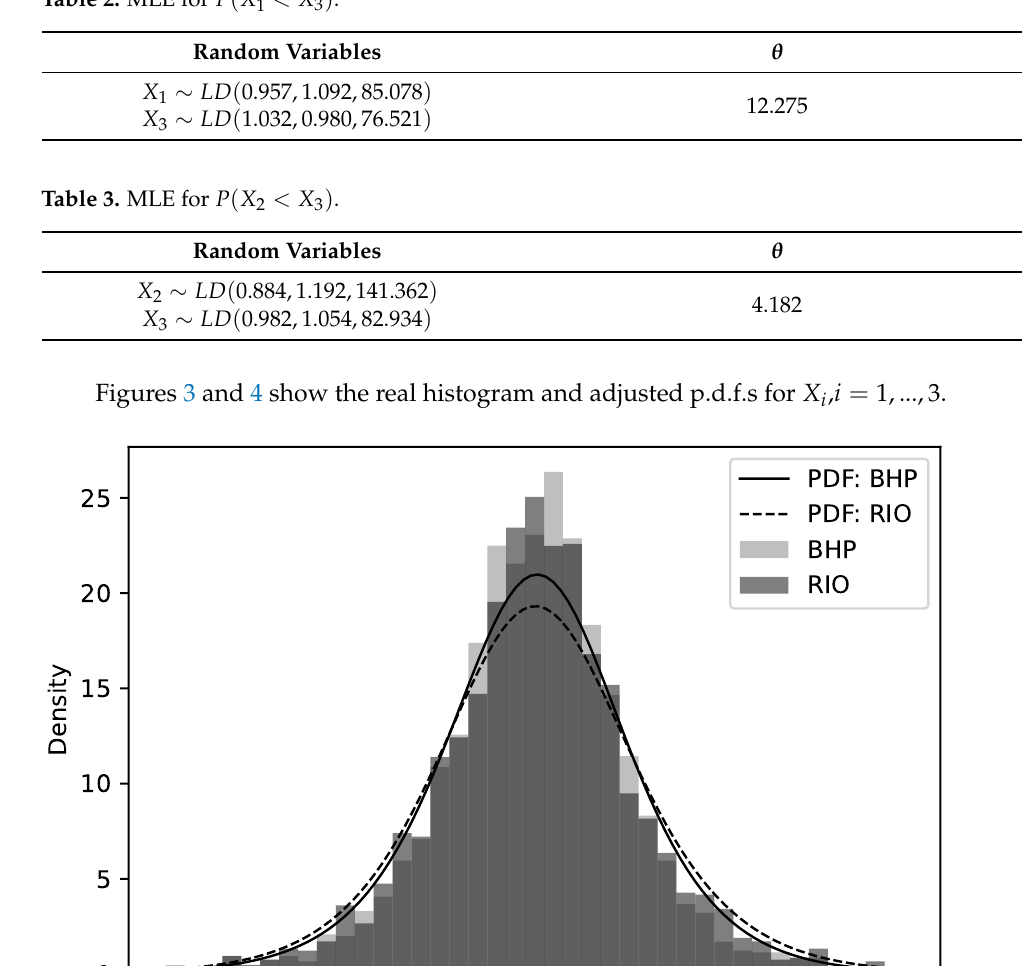
Table 2. MLE for P ( X 1 < X 3 ) .